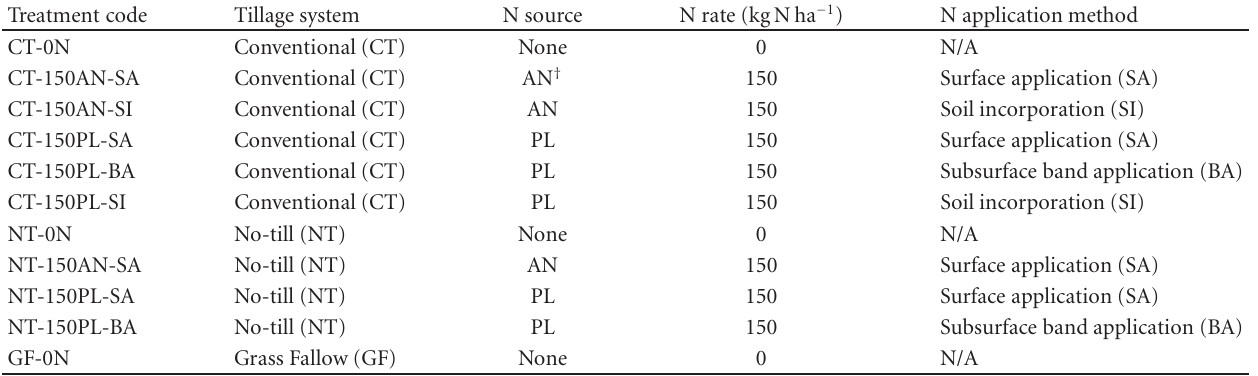
Table 2: Tillage and fertilizer treatments used in the CH 4 and N 2 O greenhouse gas flux study, Hazel Green, Alabama. Treatment